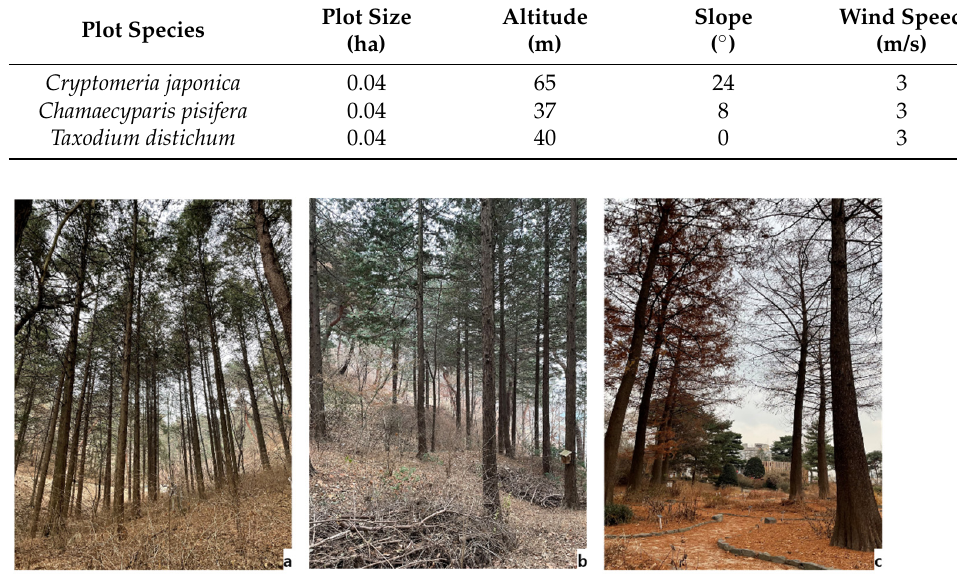
Figure 1. Landscapes of the study area. ( a ) Cryptomeria japonica, ( b ) Chamaecyparis pisifera, and ( c ) Taxodium distichum.